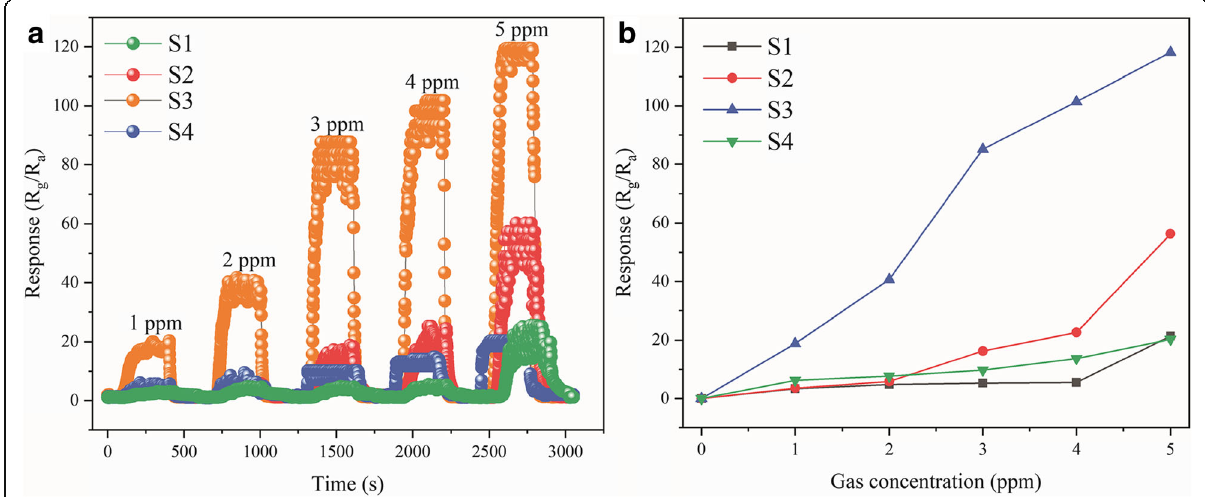
Fig. 9 a Dynamical response transients of S1, S2, S3, and S4 to methanol gas at low concentration at 195 °C. b Relationship between response and concentration of S1, S2, S3, and S4 to different methanol gas concentration (1 ppm, 2 ppm, 3 ppm, 4 ppm, and 5 ppm) at 195